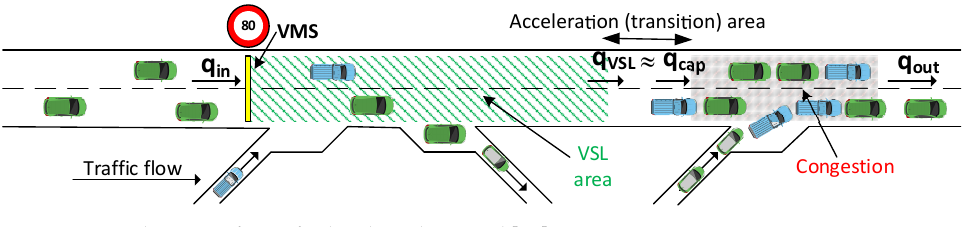
Figure 1. Application of VSL for bottleneck control